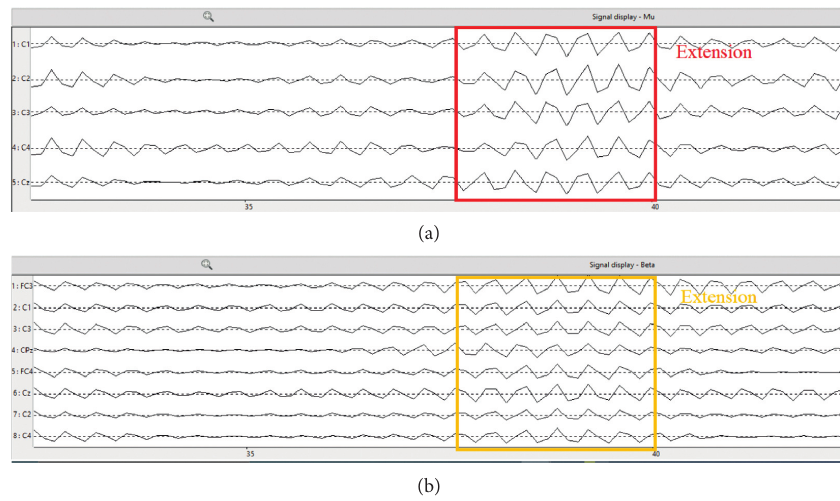
Figure 14: The behavior of the mu and beta rhythms at the extension